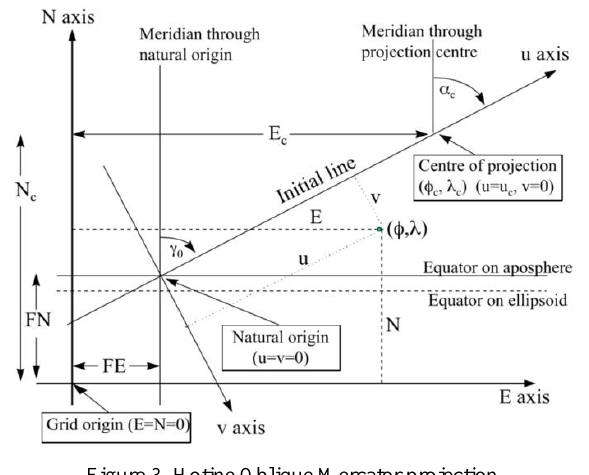
Figure 3. Hotine Oblique Mercator projection (Source: OGP Publication 373-7-2)